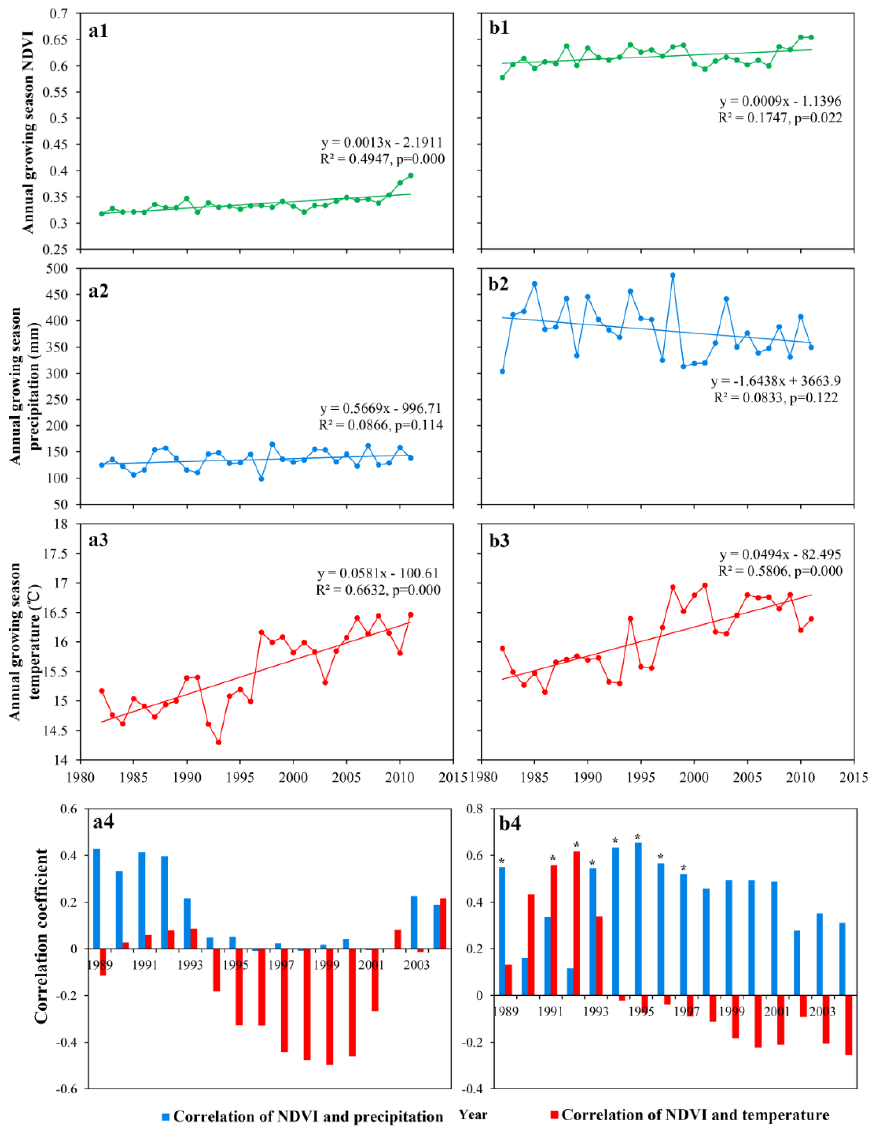
Figure 7. Interannual variations in ( a1 , b1 ) growing-season NDVI, ( a2 , b2 ) growing-season precipitation, and ( a3 , b3 ) growing-season temperature and the correlation coefficients between NDVI and ( a4 ) precipitation and ( b4 ) temperature based on 15-year moving windows in the two sub-regions. The letter “a” represents the western region, and “b” represents the eastern region. * Significant correlation at p <